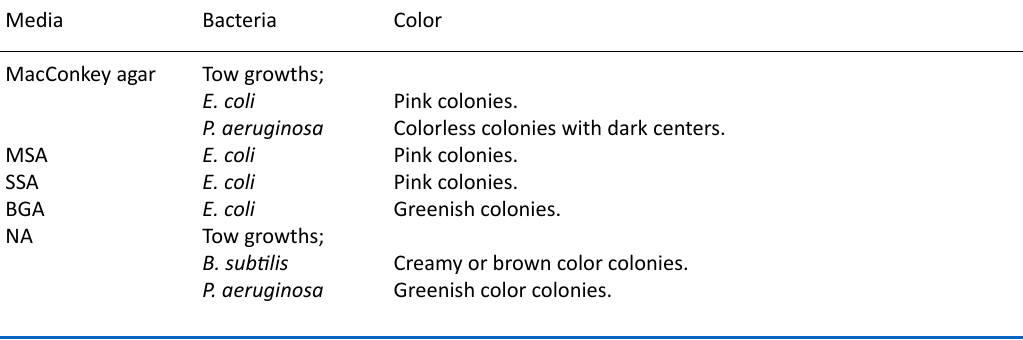
table 5. Colony characterization by using differential media